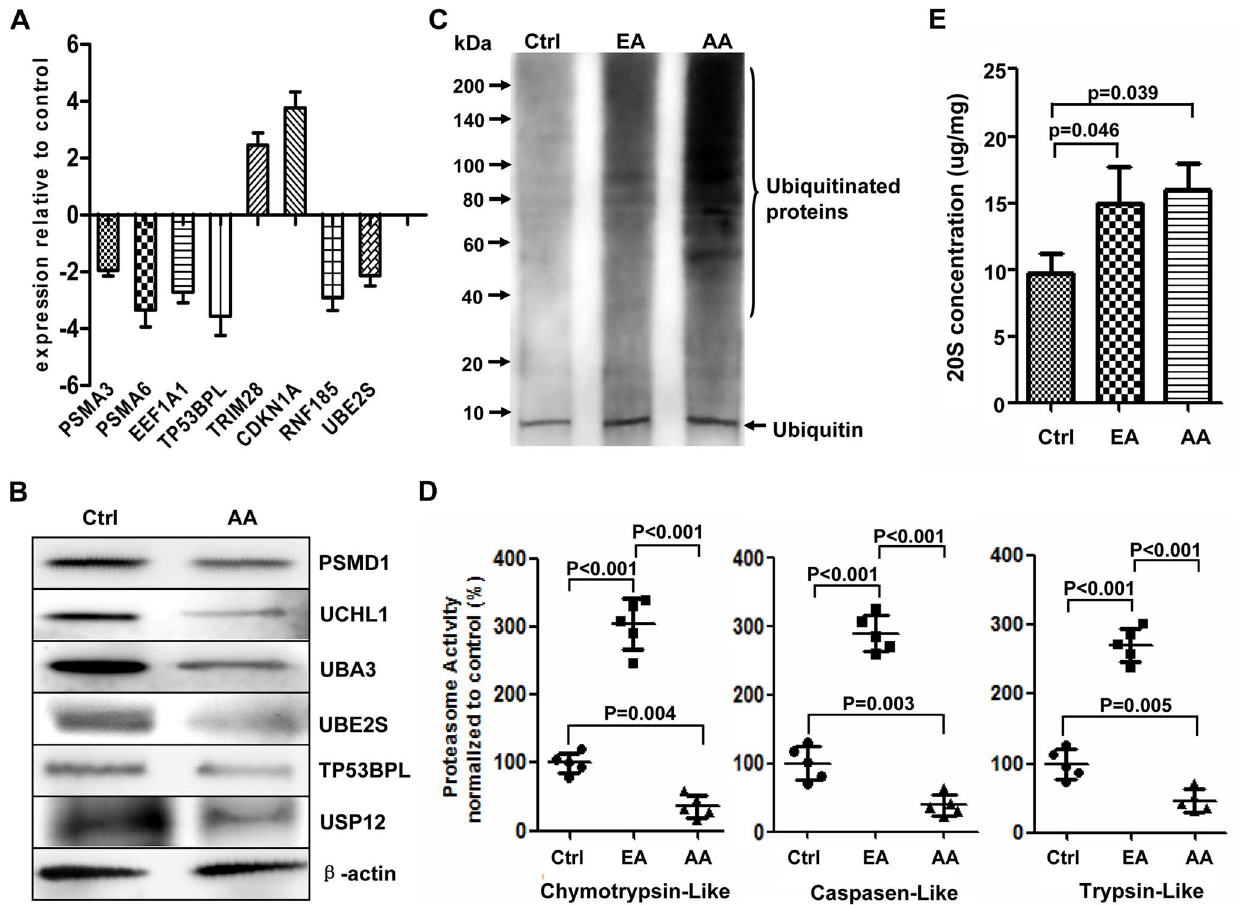
Figure 5. Analysis of the ubiquitin proteasome system in atherosclerotic plaques. ( A ) Eight key genes in figure 3B were validated by TaqMan qPCR in 20 atherosclerotic plaques and 20 controls (n=20). The results of the t test indicated they were all significantly modulated in advanced atherosclerotic plaques compared to the normal controls (p , 0.05). The positive fold change indicated upregulation and negative fold change indicated downregulation. ( B ) The representative results of the Western Blot of some key genes in UPS in advanced atherosclerosis (AA) and normal controls (Ctrl), n=5. ( C ) The representative Western Blot of the overall protein ubiquitination in Ctrl, early atherosclerosis (EA) and AA, n=5. ( D ) The proteasome activity (chymotrypsin-like, trypsin-like and caspase-like activity) in Ctrl, EA and AA was assayed. The three kinds of protease activities of proteasome in EA and AA groups were all normalized to the corresponding activity in Ctrl group. n=5, P values were shown in the figure. ( E ) The concentration of 20S proteasome (the core subunit of proteasome) in Ctrl, EA and AA was determined. Its amount was calculated per mg total protein. P values were shown in the figure. n=5. There was no significant difference between EA and AA.